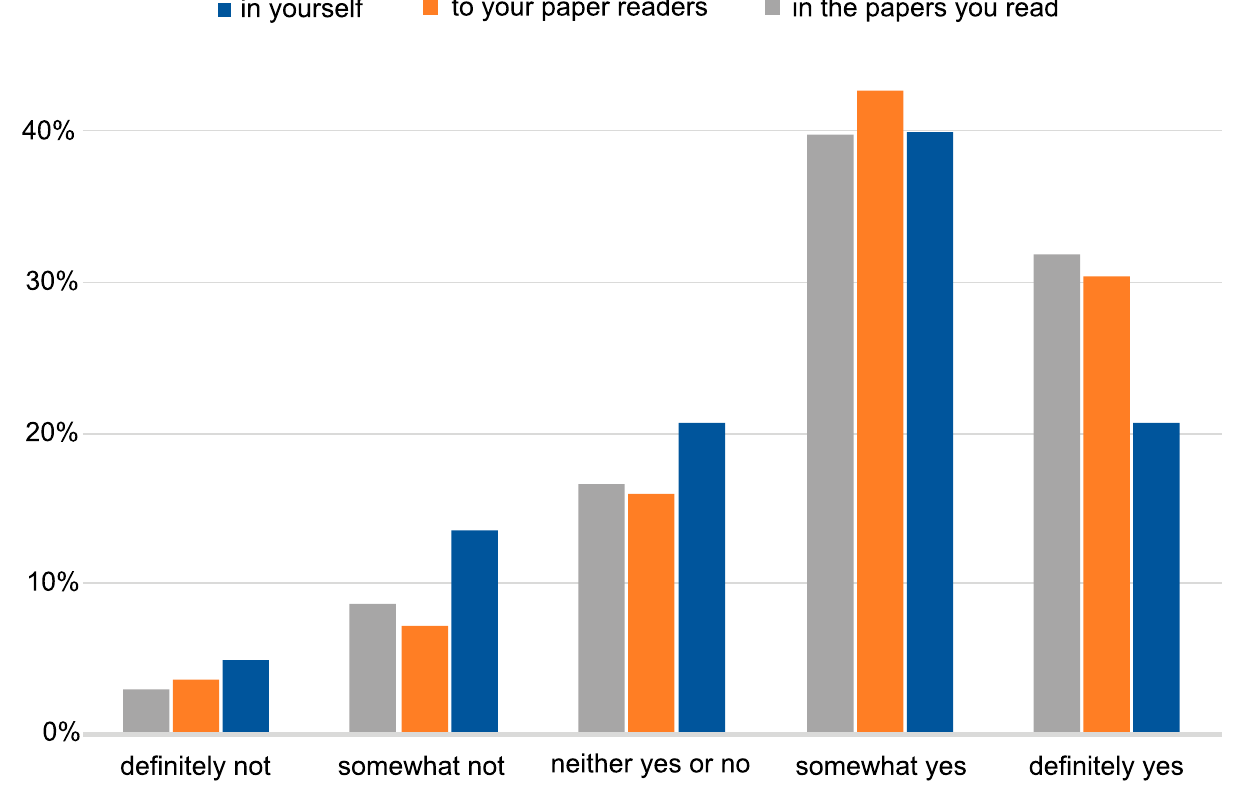
Frontiers in Research Metrics and Analytics |